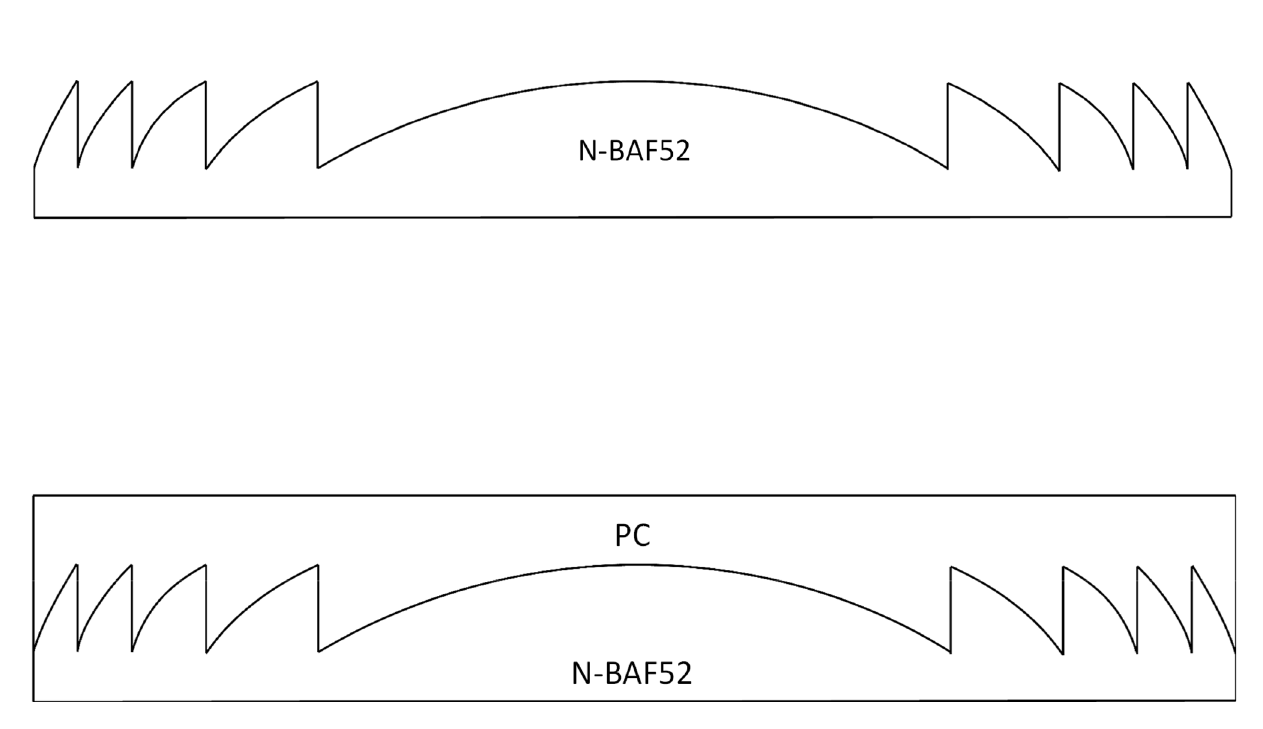
Figure 4. Difference between SM-DFL and TM-DFL. ( a ) material composed of a SM-DFL ( b ) material composed of a TM-DFL ( c ) diffraction efficiency of SM-DFL at m = 1 ( d ) diffraction efficiency of TM-DFL at m =